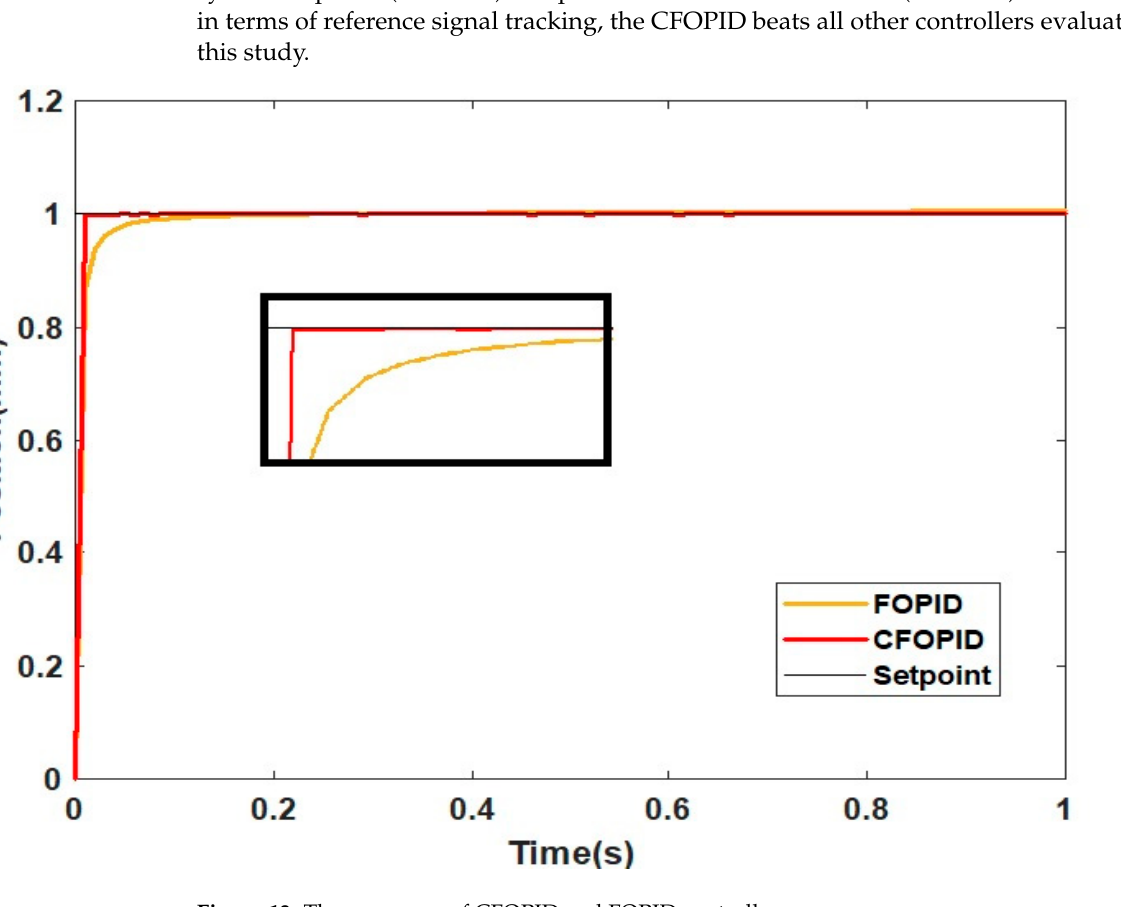
Figure 14. The CFOPID and FOPID controllers’ responses with varying setpoint.